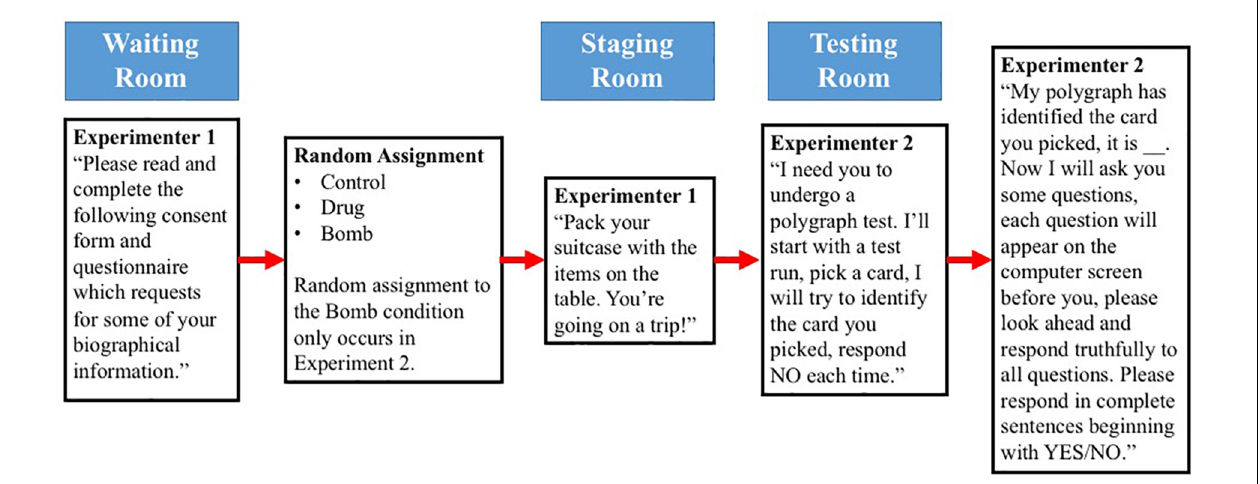
FIGURE 2 | Layout of experimental procedure from perspective of